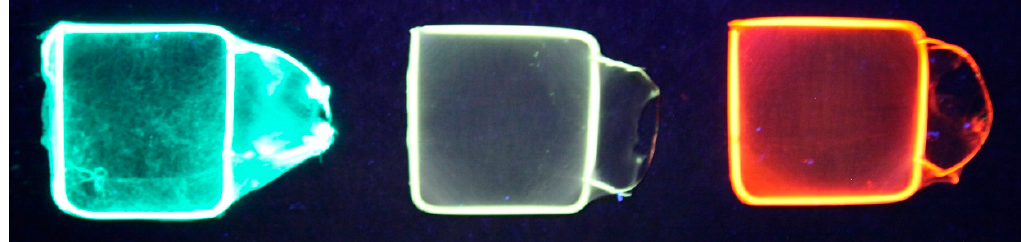
Figure 9. Blue-green (coumarin 7 (C7))-, white-light (mixture 2)-, and orange-red (sulforhodamine 101 (SRh 101))-emitting flexible and thin fiber mats under UV light excitation (365 nm).